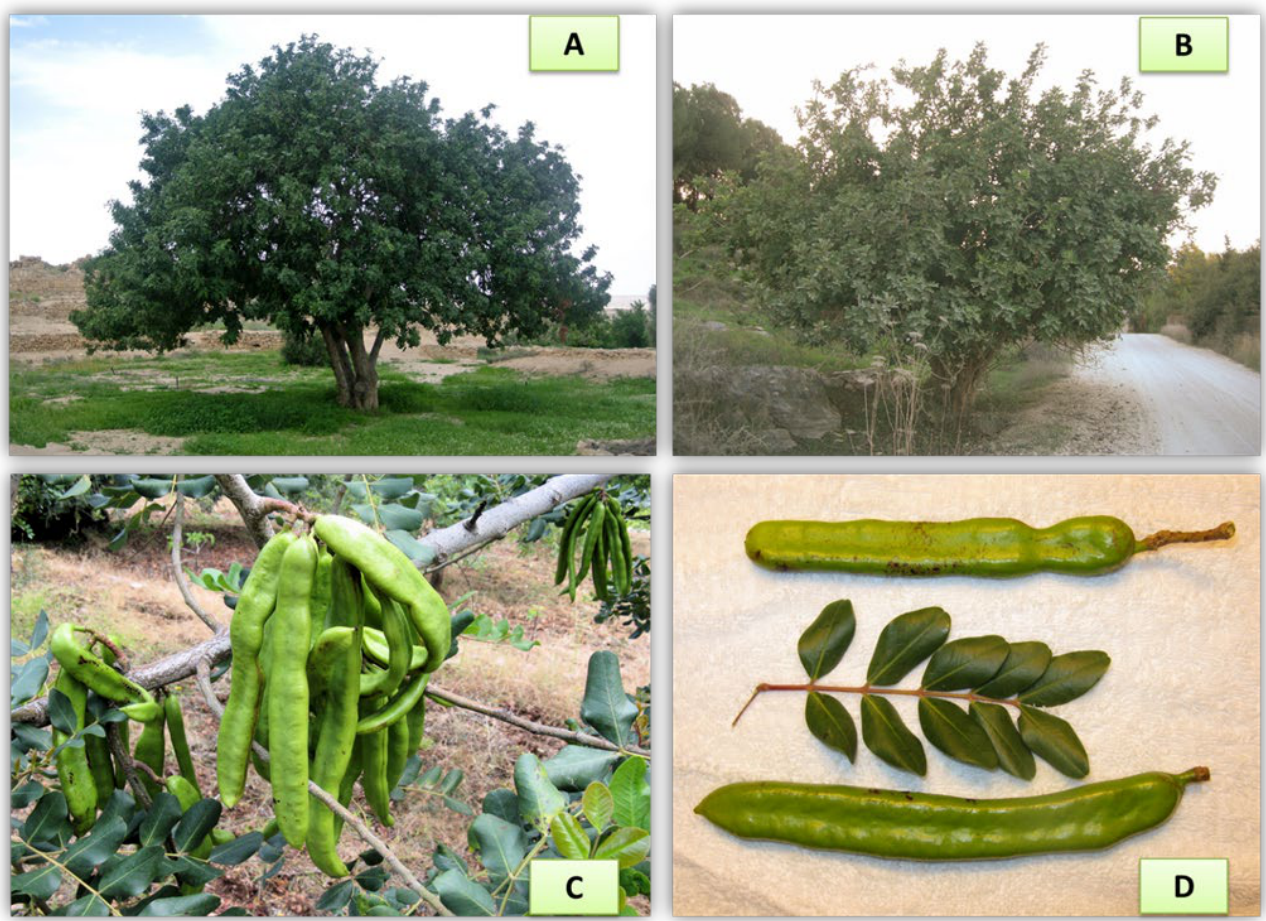
Figure 1. The carob tree ( A , B ) and the carob pod ( C , D ).